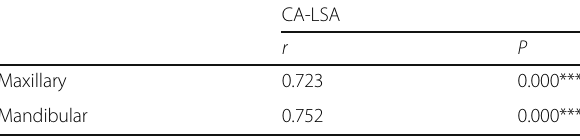
Table 5 Pearson correlation analysis indicated the significant positive correlation between CA and LSA (maxillary: r = 0.723,